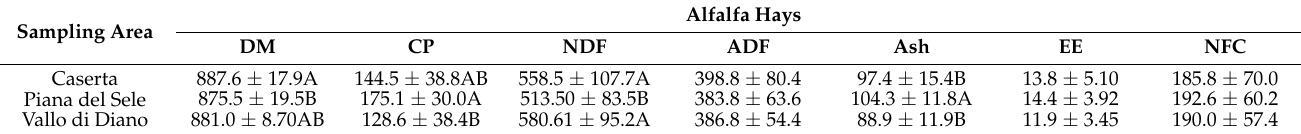
Table 5. Chemical composition (g/kg as fed; mean ± SD) of alfalfa hays according to the sampling area.